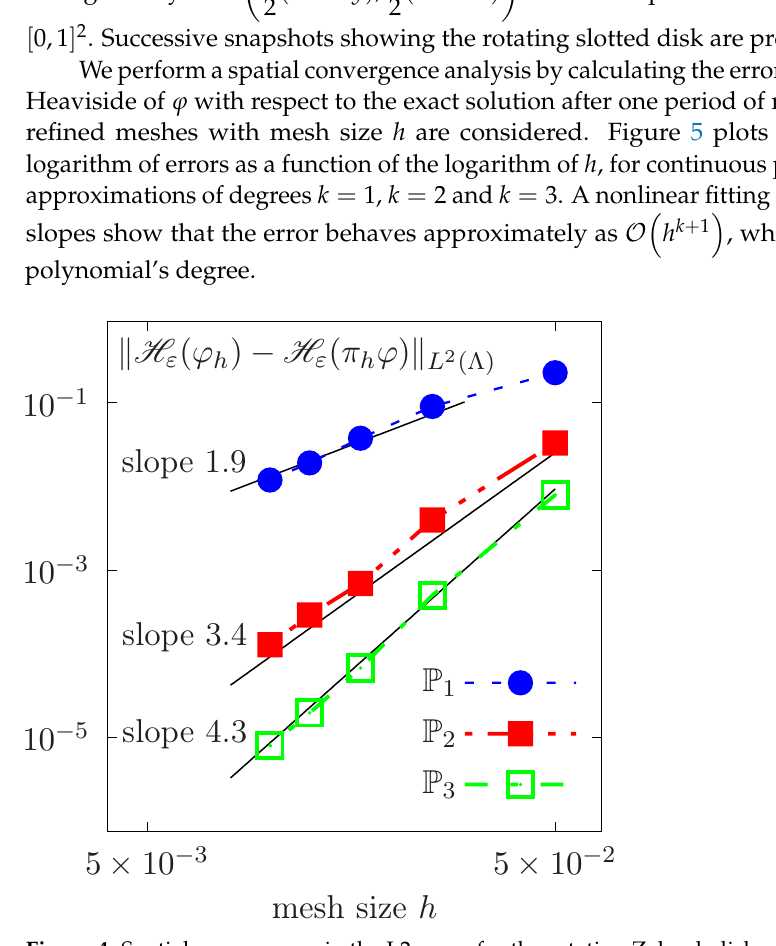
Figure 4. Spatial convergence in the L2 norm for the rotating Zalesak disk as a function of the mesh size h